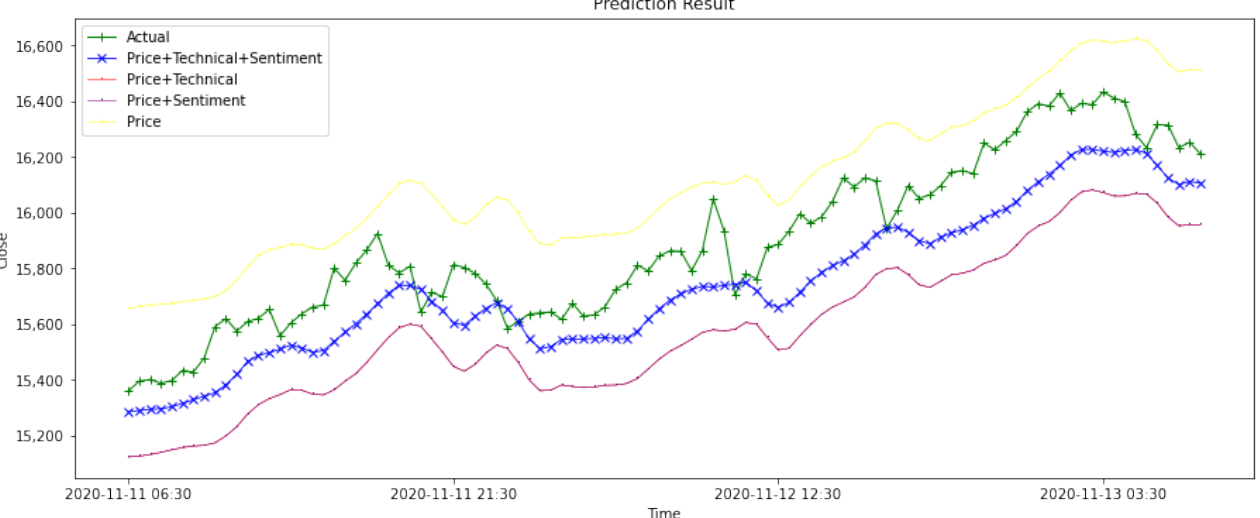
Figure 12. Stacking ensemble model prediction result for different data combinations.